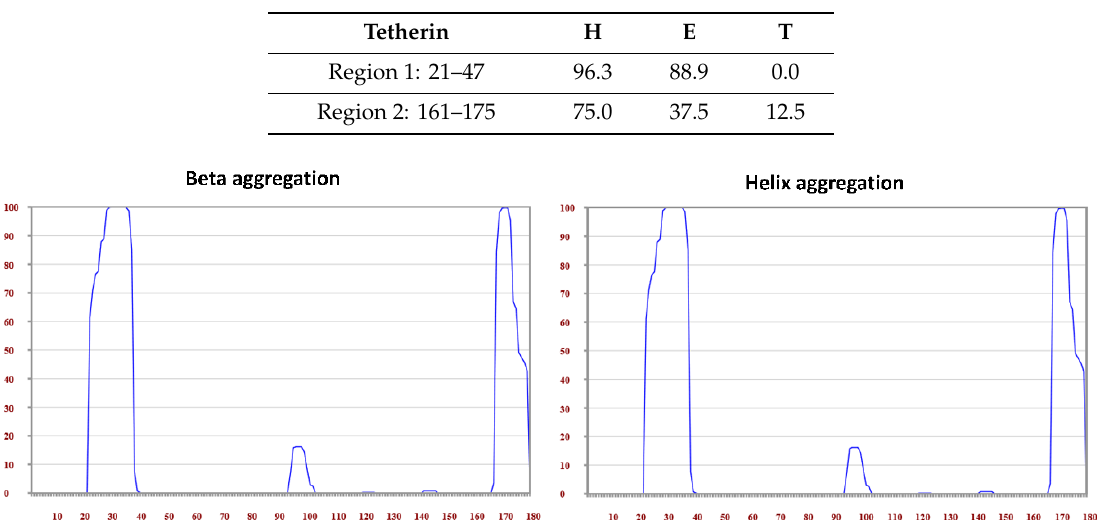
Figure 9. Beta aggregation and Helix aggregation plots generated in TANGO highlighting regions 22—38 and 168—179 to have high aggregation probability .